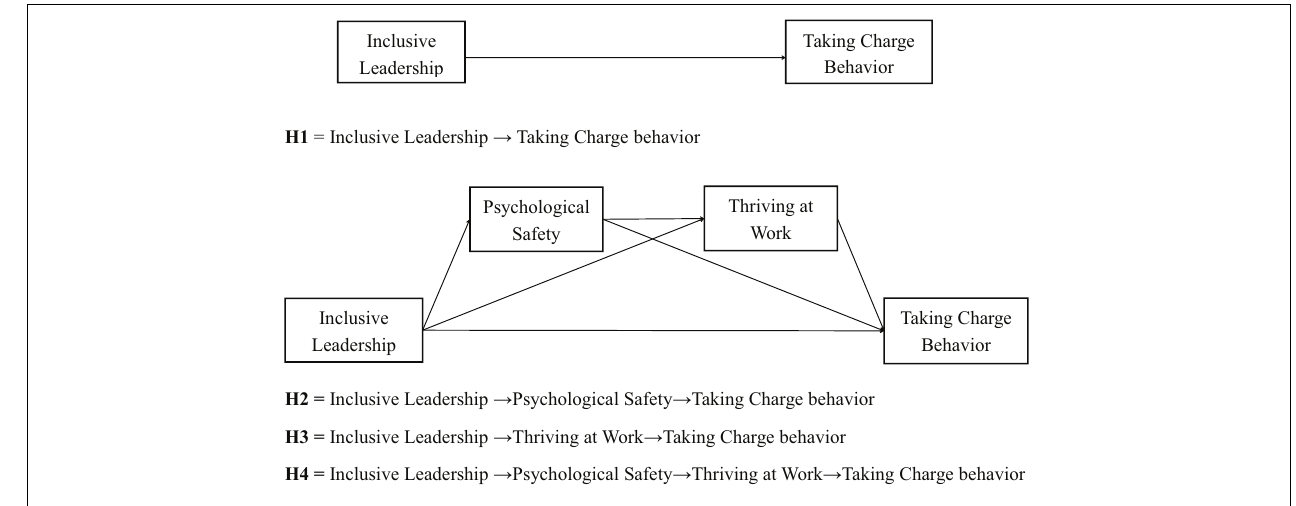
FIGURE 1 | Empirical